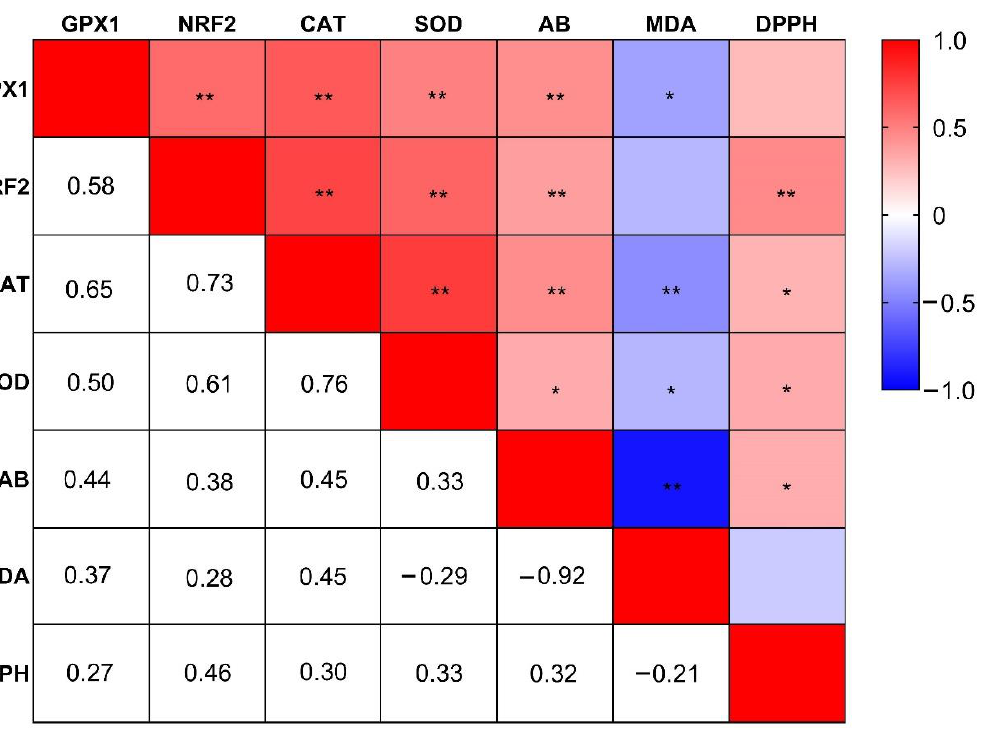
Figure 3. Pearson correlation heat map between hepatic antioxidant-related gene expressions and oxidative stress markers in plasma. The red color indicates a positive correlation; the blue color indicates a negative correlation and the white color indicates no correlation. Pearson r values were calculated using the IBM SPSS Statistics for Windows software (IBM SPSS 27; IBM Corp., Armonk, NY, USA). The heat map was realized using Graph Pad Prism 8 (GraphPad, La Jolla, CA, USA). Abbreviations: NRF2, nuclear factor erythroid 2-related factor; SOD, superoxide dismutase; CAT, catalase; GPX1, glutathione peroxidase 1; AB, antioxidant balance; MDA, malondialdehyde; DPPH, 2,2-diphenyl-1-picrylhydrazyl free radical scavenging activity. ** Correlation is statistically signifi-